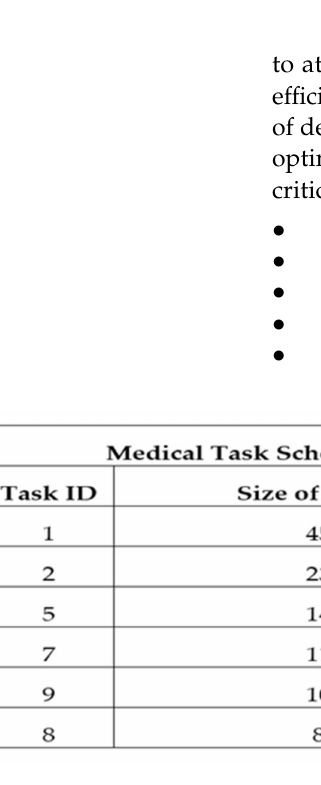
Figure 2. Medical task